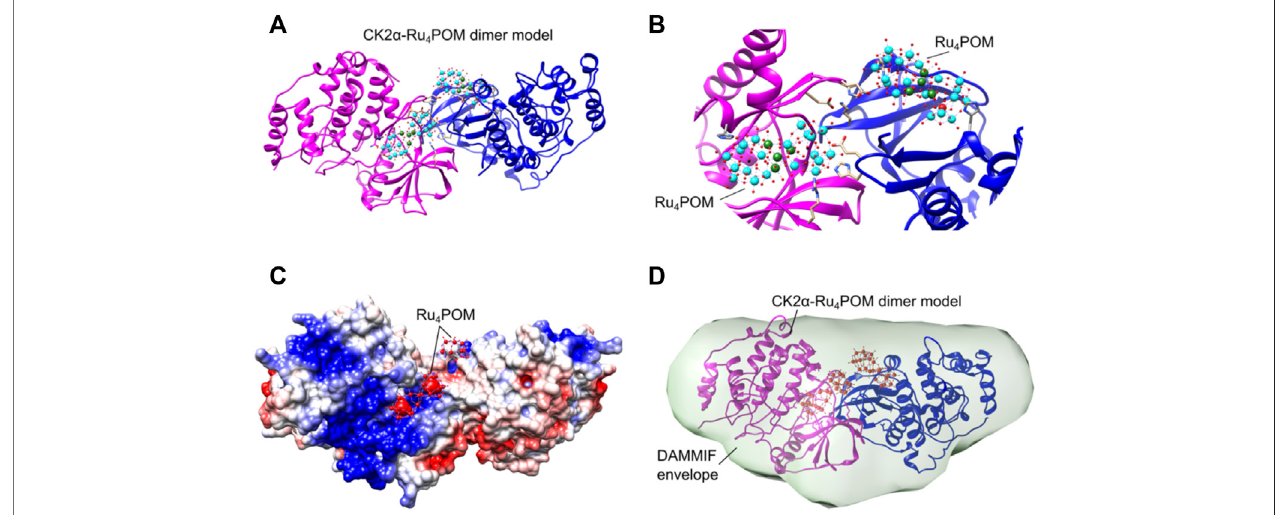
FIGURE 9 | Structural organization of the (CK2 α ) 2 (Ru 4 POM) 2 complex. (A) Proposed CK2 α -Ru 4 POM dimer model showing two interacting CK2 α (colored in magenta and blue) and two Ru 4 POM further connecting the two subunits. (B) Closer view on the CK2 α -Ru 4 POM interface. Spheres colored in cyan represent 10 W atoms, in green 4 Ru atoms, in red O atoms and in black 2 Si atoms. (C) Electrostatic surface of the CK2 α -Ru 4 POM dimer model. Positive and negative charges are depicted in blue and red, respectively. The potentials were calculated using programs PDB2PQR and APBS (Jurrus et al., 2018). (D) CK2 α -Ru 4 POM DAMMIF model (light green envelope shown in transparency) overlaid with the proposed CK2 α -Ru 4 POM dimer model.